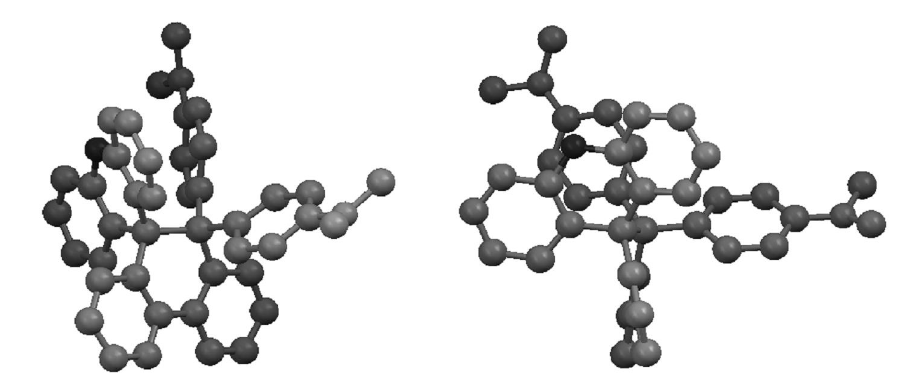
Figure 2. Molecular structure of 1NX determined by X-ray analysis: ( left ) top view; ( right ) side view. The DHP skeleton adopts a helical geometry, and all of the molecules in a single crystal are homochiral in terms of helicity.